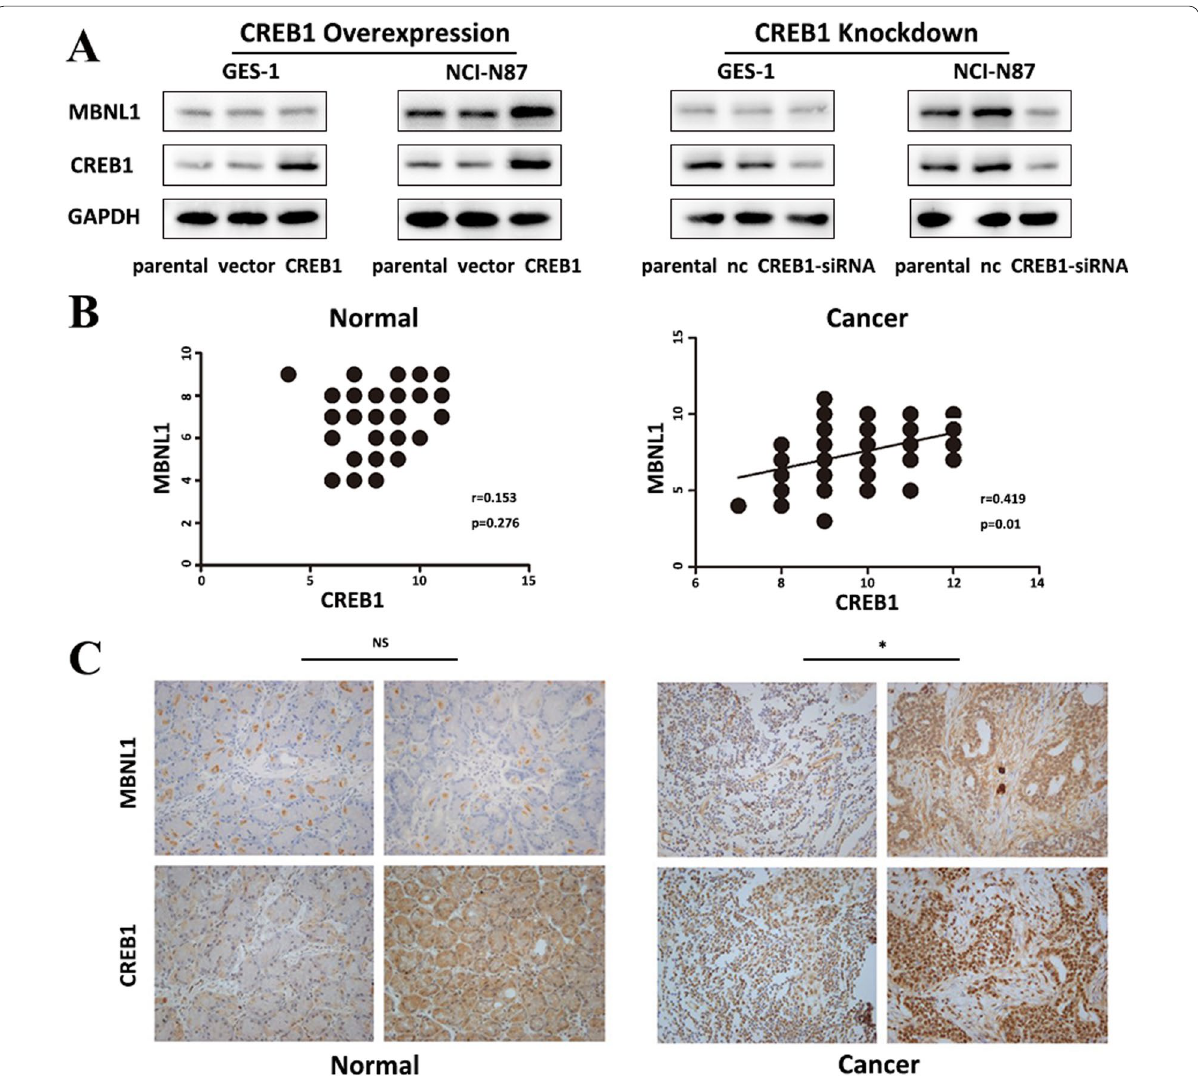
Fig. 5 CREB1 differentially regulated MBNL1 under normal and cancer stages. A Western blot analysis for MBNL1 expression was performed with cell lysate from GES‑1 and NCI‑N87 transfected with CREB1 lentivirus vectors (Left) or siRNA specific to CREB1 (Right). B Correlation between CREB1 and MBNL1 in diagnostic tumor samples (n of CREB1 and MBNL1 in tumor and normal samples (400 and MBNL1 expression was analyzed by Spearman